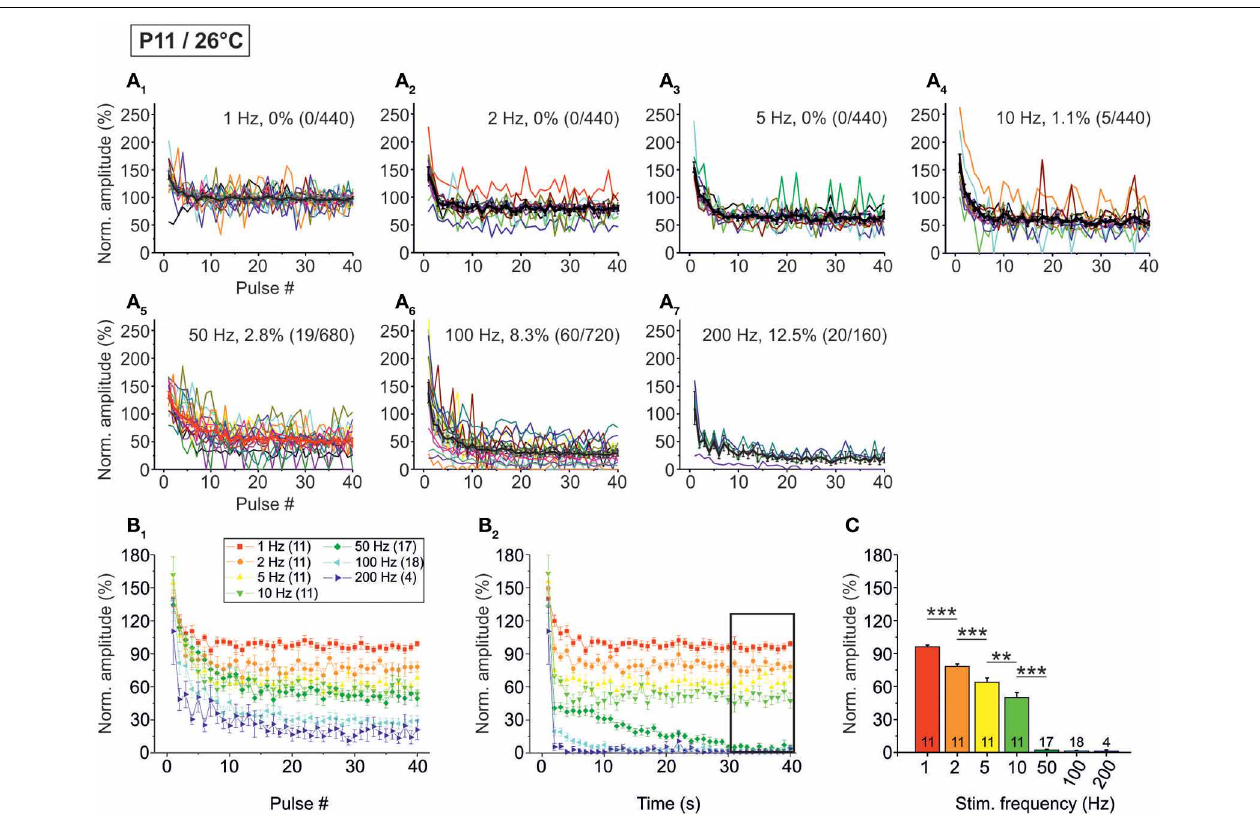
FIGURE 5 | Population data illustrating the frequency-dependent time course of glycinergic IPSC peak amplitudes at P11/26 ◦ C. (A 1 –A 7 ) Color-coded plots for all recorded LSO neurons at seven stimulation frequencies ( n = 4–18, cf. inset in panel B 1 ), depicting the time course of IPSC amplitudes during the first 40 stimulus pulses. In each panel, the mean values ± s.e.m. are shown in black. The failure rate (%) and the ratio failures/events across neurons are also provided in each panel. (B 1 ) Mean values ± s.e.m. of the first 40 IPSCs obtained in response to different